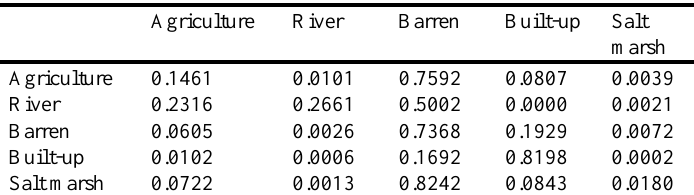
Table 3. Ahvaz transition probability matrix 2000 -